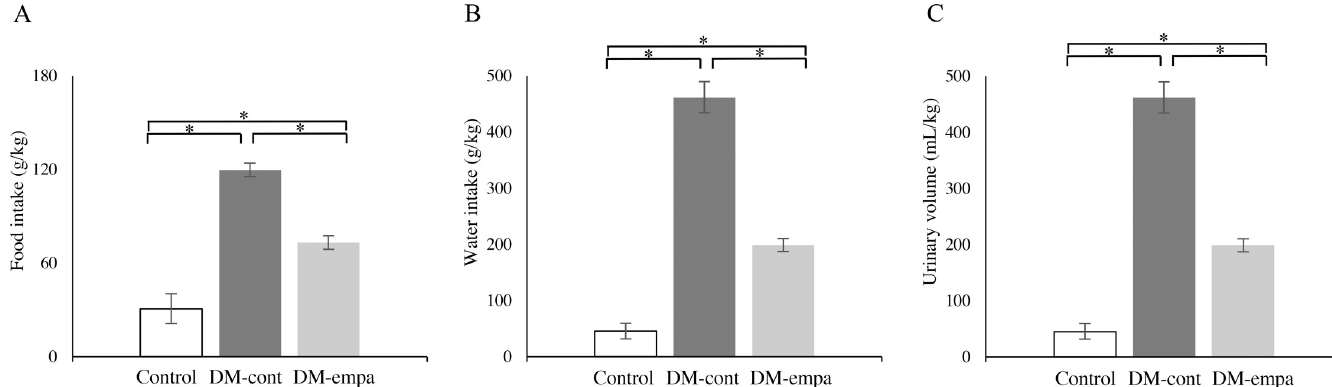
Fig 3. Effects of empagliflozin on food and water intake and urinary volume. Food intake (A), water intake (B) and urinary volume (C) over 24 h of rats in the control (n = 3), DM-cont (n = 3) and DM-empa (n = 3) groups during week 12. All data were expressed as relative to body weight. � p < 0.05.